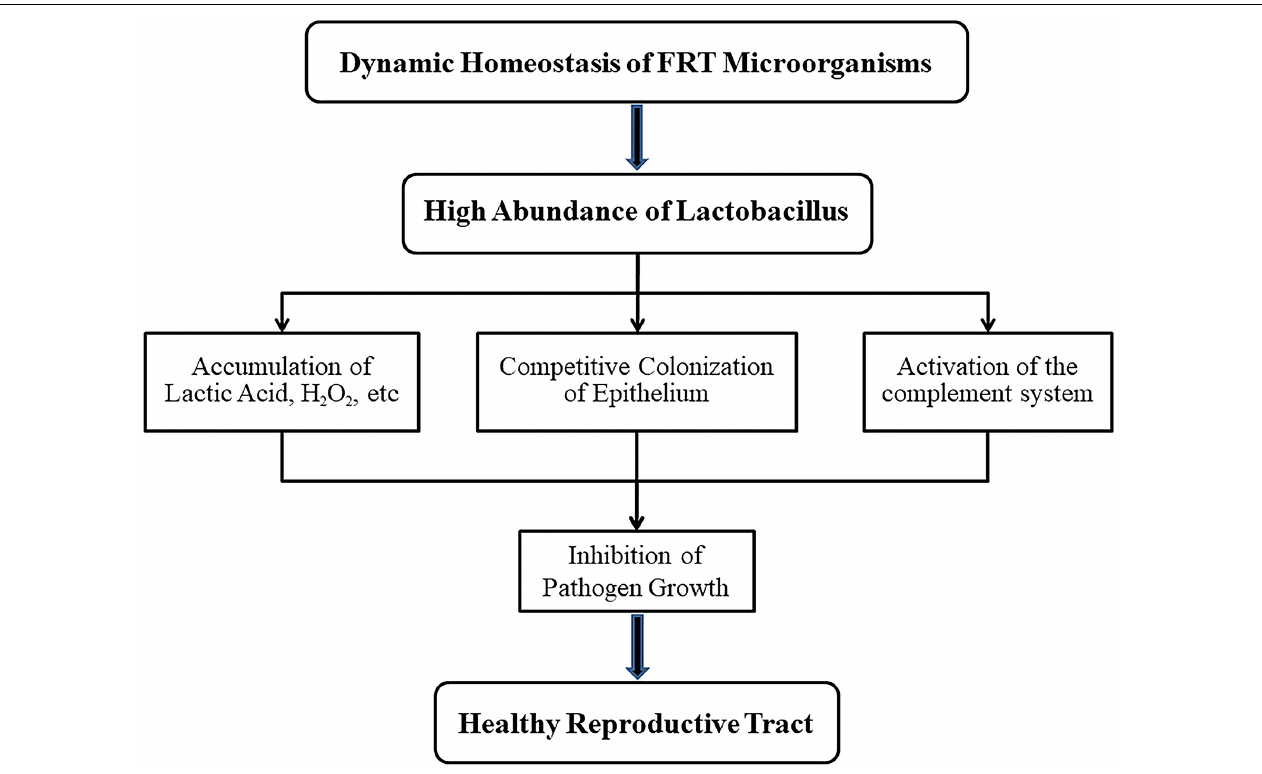
FIGURE 2 | Mechanisms of lactobacillus maintaining health for female reproductive tract (FRT). When the microbial community of female reproductive tract is in dynamic balance, lactobacillus with high abundance will not only produce lactic acid, H 2 O 2 and other products but also compete with anaerobic bacteria for vaginal epithelial cells. In addition, the complement system could be activated by lactobacillus . These features prevent the growth of pathogens and thus ensure the health of the